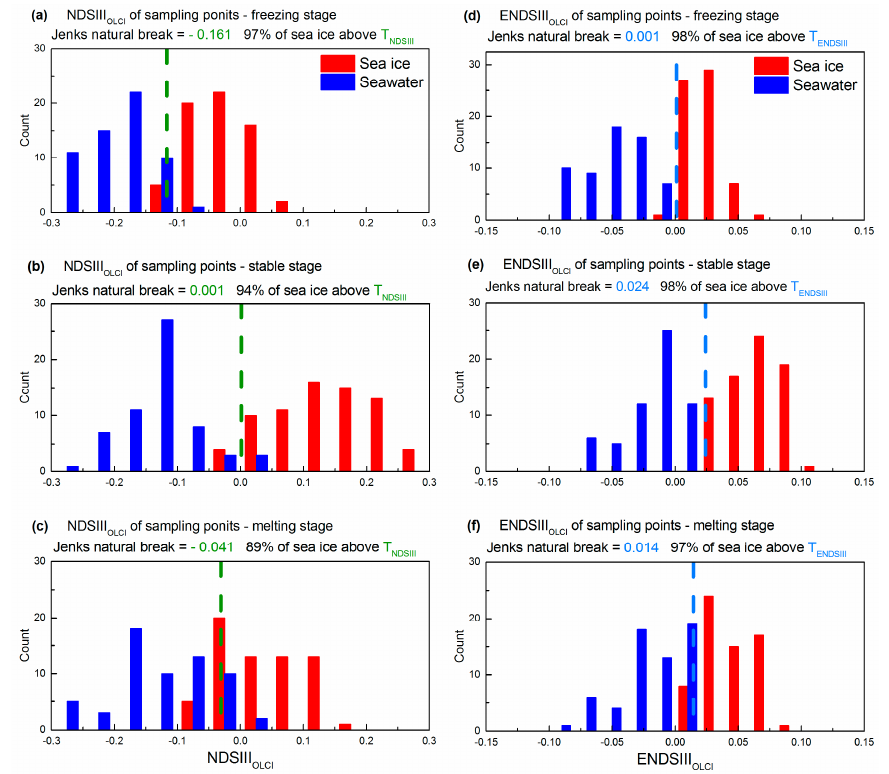
Figure 3. Sample TOA reflectance values for sea ice and turbid seawater in OLCI Bands 12, 16, 20, and 21 in the Bohai Sea.